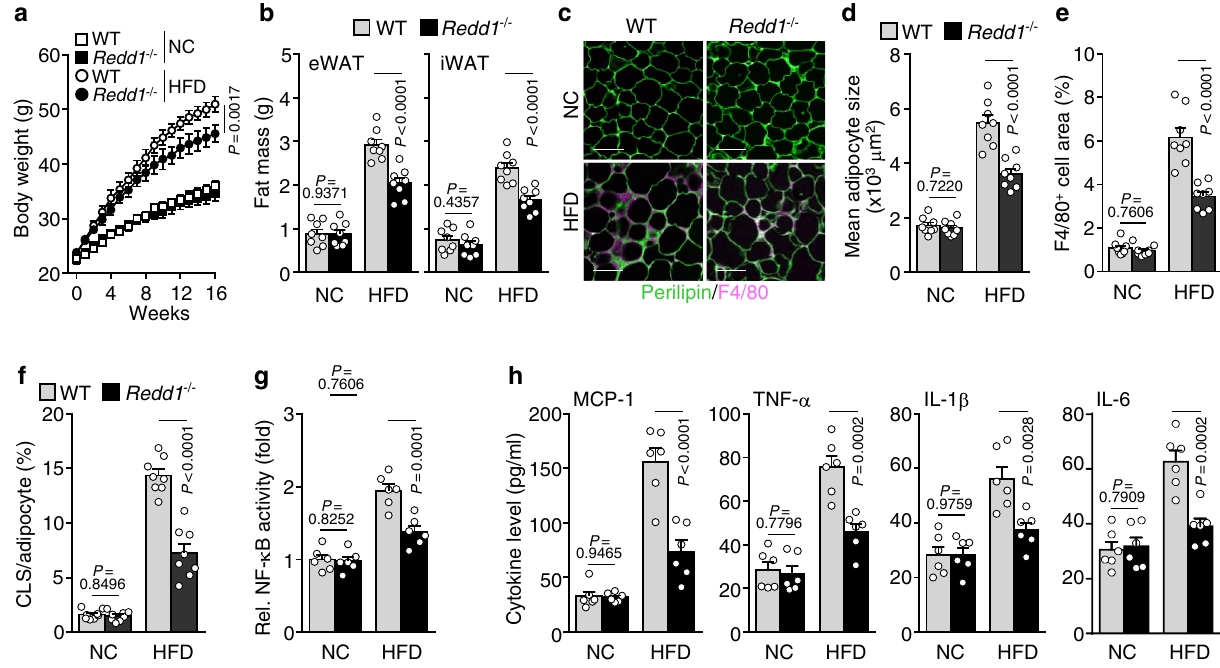
Fig. 1 | Redd1 − / − mice are protected against HFD-induced weight gain and adi- posetissueexpansion.a Weightgainin Redd1 − / − miceandtheirWTlittermatesfed NCorHFDfor16weeks( n =6pergroup). b MassofeWATandiWATinNC-orHFD- fed Redd1 − / − mice and their WT littermates ( n =8 per group). c Representative images ofperilipin(green) and F4/80(purple) staining inthe eWATof NC- or HFD- fed Redd1 − / − mice and WT littermates ( n =8 per group). Scale bar, 100 μ m. d Average adipocyte size in the eWAT of NC- or HFD-fed Redd1 − / − mice and WT littermates ( n =8 per group). e Relative area of F4/80-positive cells in the eWAT of